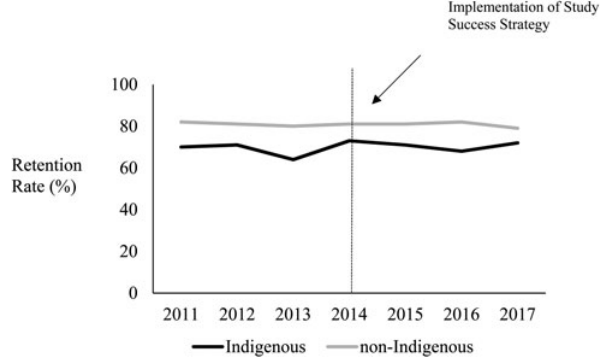
Fig. 2. Indigenous and non-Indigenous student retention rates, 2011 – 2017. Note : Indigenous student N =193 – 283. Non-Indigenous student N =13,109 – 14,065.